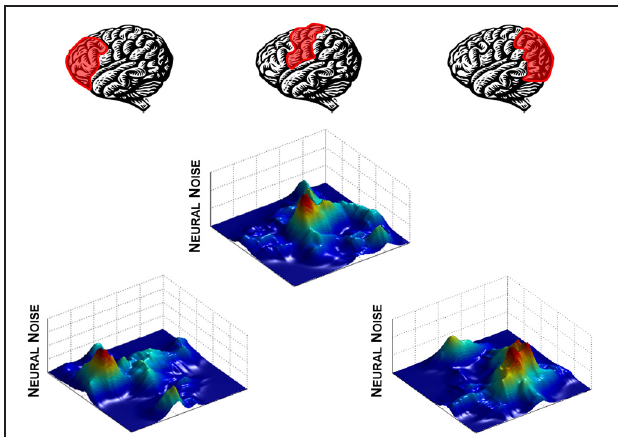
FIGURE 2 | Neural noise modulation across the brain viewed as landscape. Here, levels of neural noise are represented as peaks and valleys on a landscape “map” of a brain unfolded as a two-dimensional surface. Noise is shifted from one brain region to another to alter the signal-to-noise ratio, depending on which region is playing a primary functional role.